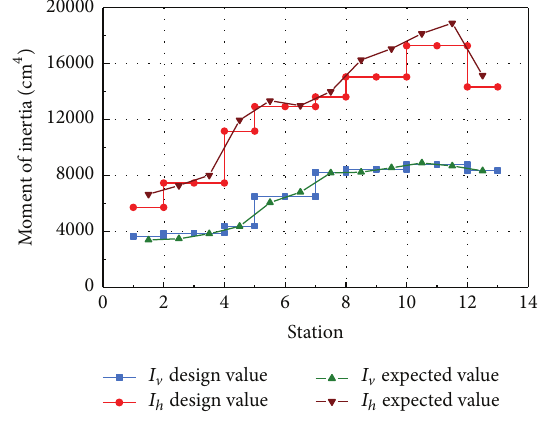
Figure 5: Comparison of moments of inertia.